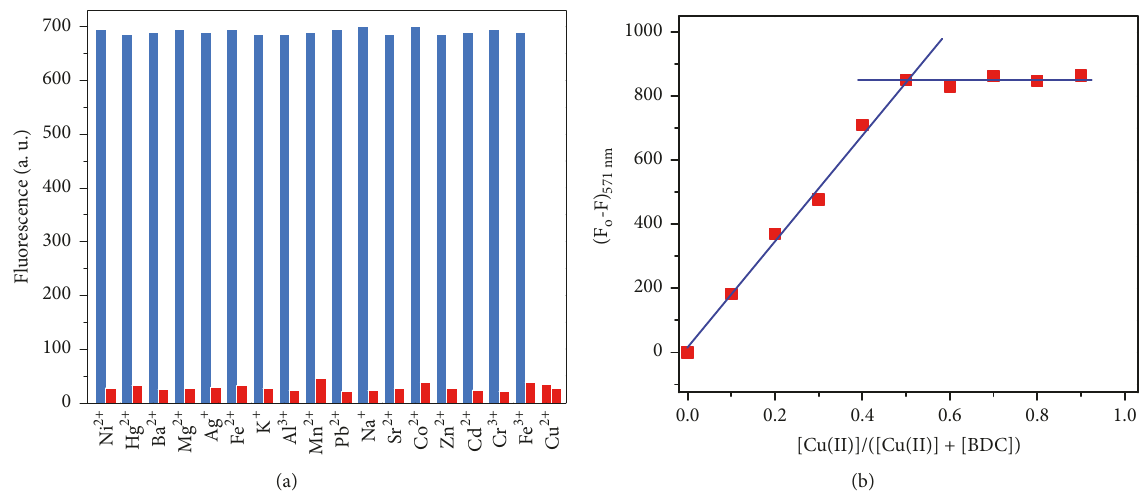
Figure 5: (a) Emission intensity of BDC chemosensor probe (I) in the presence of different cations (blue bar) and (II) in the presence of same cations besides Cu(II) ions (red bar). BDC: Cu(II): M(II) is equal to 1:1:1 ( 𝜆 ex = 401 nm); (b) Job’s plot for detection the stoichiometric chelation of BDC with Cu(II) ion in 1:9 (v/v) methanol-HEPES buffer solution (pH = 7.2); fluorescence intensities versus mole fraction of Cu(II) ion were